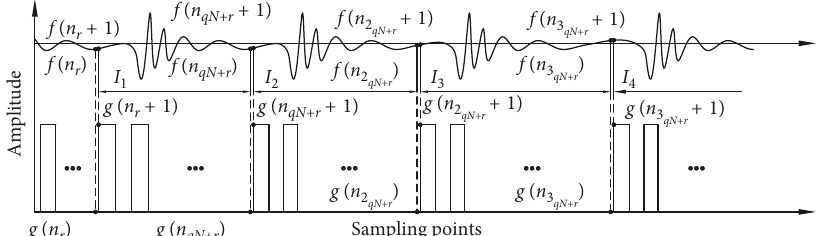
Figure 10: Acquisition principle of I edge, is selected as the first point of I j , and f ( n jqN+r ) corresponding to g ( n jqN+r ), which is used to judge the ( jqN + r )th rising edge, is set as the last point of I j .